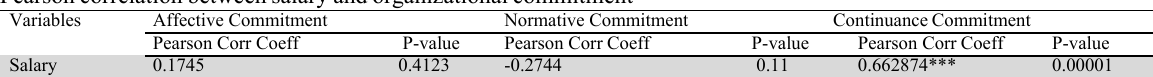
Pearson correlation between salary and organizational commitment Variables Affective Commitment